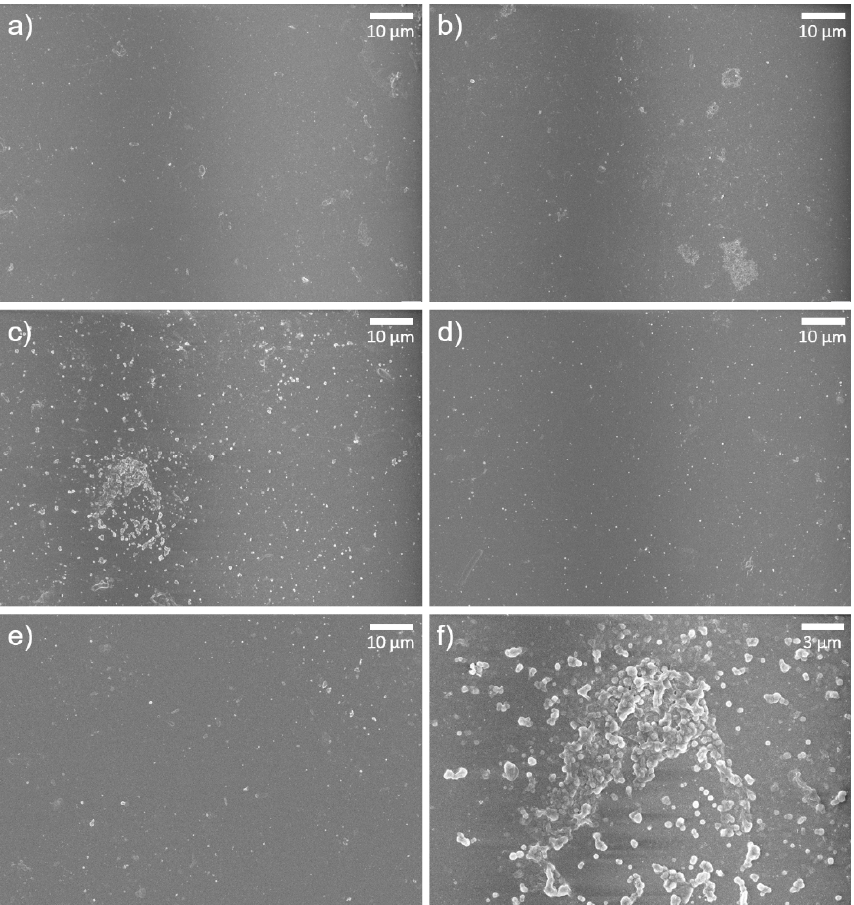
Figure 5. SEM images of ( a ) TFC, ( b ) GONs-TFC (20 ppm), ( c ) GONs-TFC (40 ppm), ( d ) o-SWNTs- TFC (20 ppm), and ( e ) o-SWNTs-TFC (40 ppm) membranes at 3000× magnification, and ( f ) a GONs- TFC (20 ppm), and ( e ) o-SWNTs-TFC (40 ppm) membranes at 3000 × magnification, and ( f ) a GONs- TFC membrane (40 ppm) at 10,000× magnification. These images were acquired after the acid re- TFC membrane (40 ppm) at 10,000 × magnification. These images were acquired after the acid sistance test. resistance